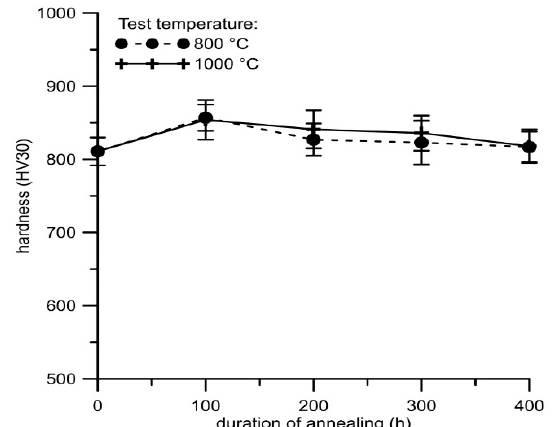
Figure 11. Hardness of FeAl20Si20 alloy after annealing at 800 and 1000 ◦ C vs. duration of annealing.